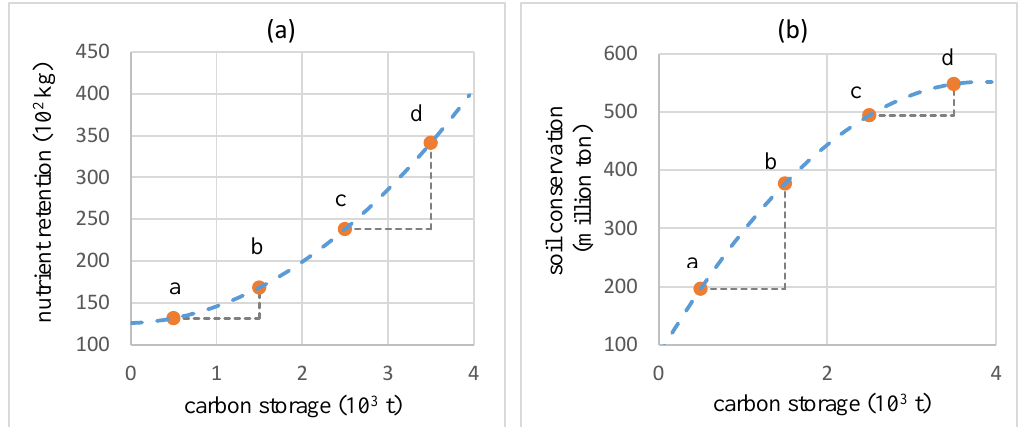
Figure 10. Production possibility frontier curve for nutrient retention and carbon storage ( a ); production possibility frontier curve for soil conservation and carbon storage ( b ).